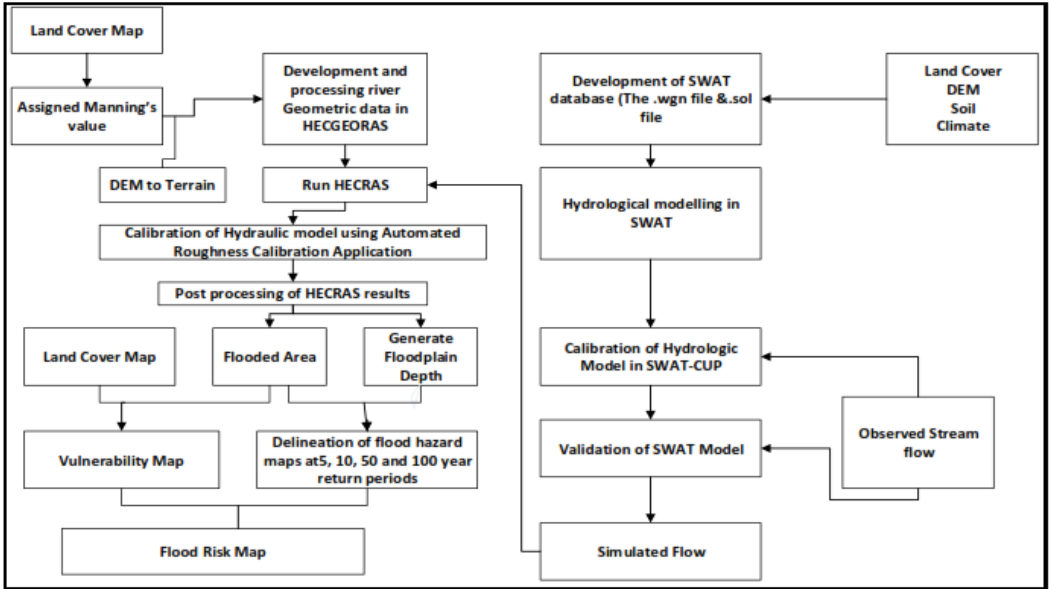
Figure 3. Schematic of Data and Models for flood prediction and analysis.